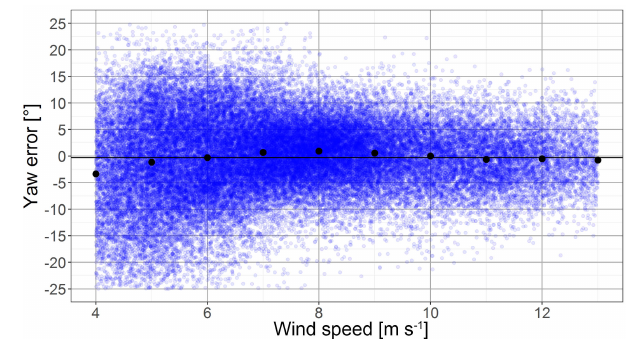
Figure 3. Turbine alignment check based on the comparison of a ground-based lidar wind direction measured with the velocity az- imuth display (VAD) technique and the turbine wind direction (yaw error) plotted against the wind speed. The median yaw error per wind speed bin is indicated by the black dots and the overall mean by a horizontal line. Data are averages of 1min periods and obtained from the experimental setup described in Sect.